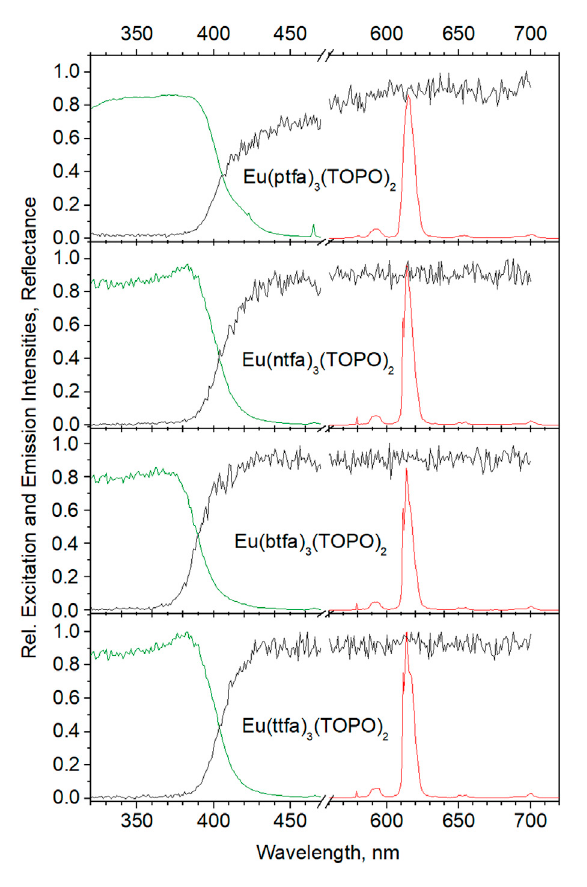
FIGURE 2 Re fl ectance, excitation and emission spectra of Eu(diketonate) 3 (TOPO) 2 complexes in KBr (1% wt): F 0 → 5 D 2 (465 nm),